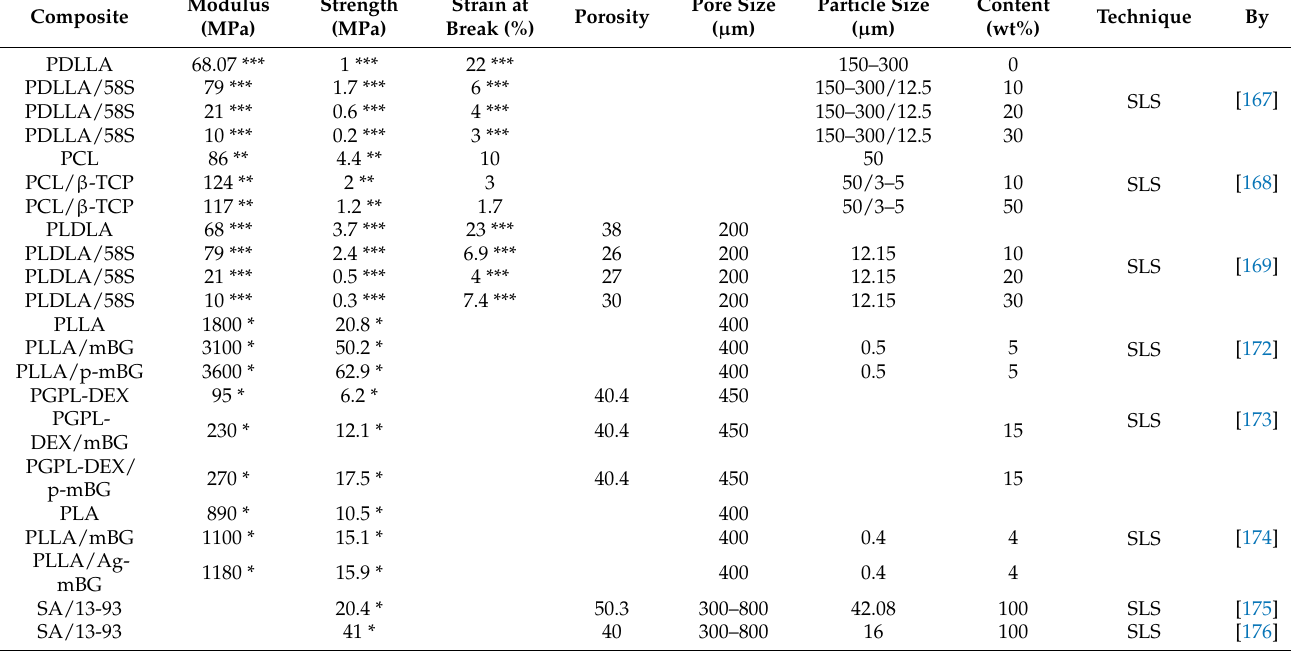
Table 7. Principal properties of SLS investigations. With * the compression, ** tensile and *** flexural modulus/strength. (not filled cells mean no